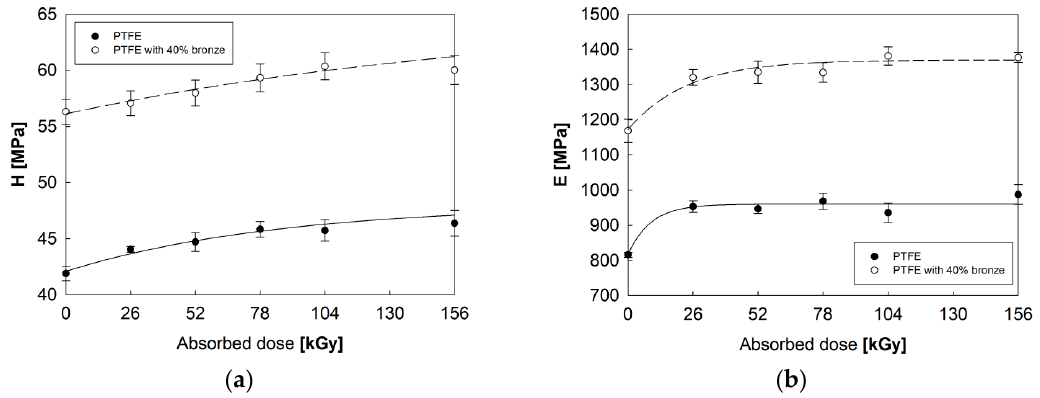
Figure 8. Changes in hardness H ( a ) and Young’s modulus E ( b ) for PTFE and PTFE with a 40% addition of bronze as a function of absorbed radiation dose.